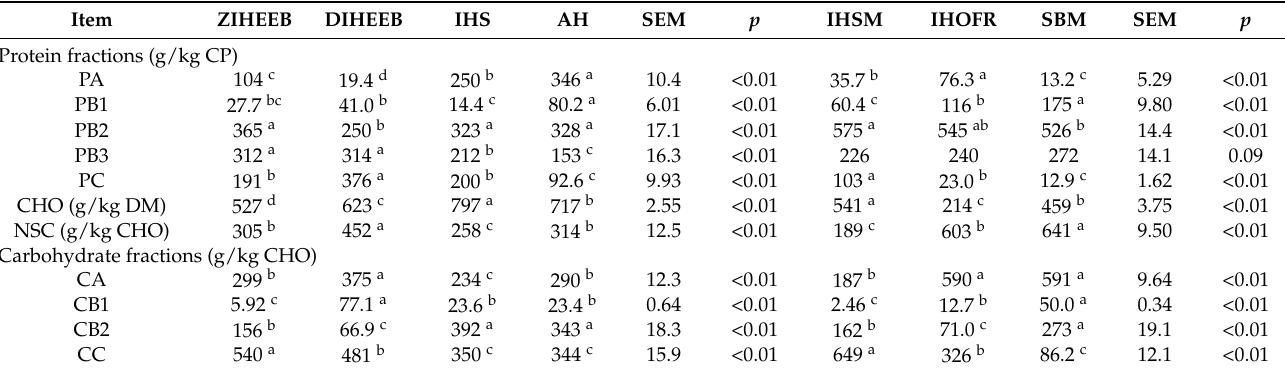
Table 2. Crude protein and carbohydrate fractions of the industrial hemp byproducts and conven- tional feeds according to the Cornell Net Carbohydrate and Protein System (CNCPS).